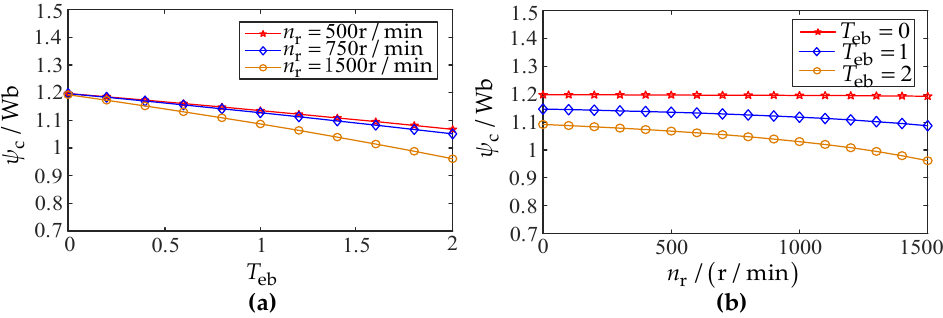
Figure 9. Reference value of the control machine’s rotor flux at different speeds and torques.